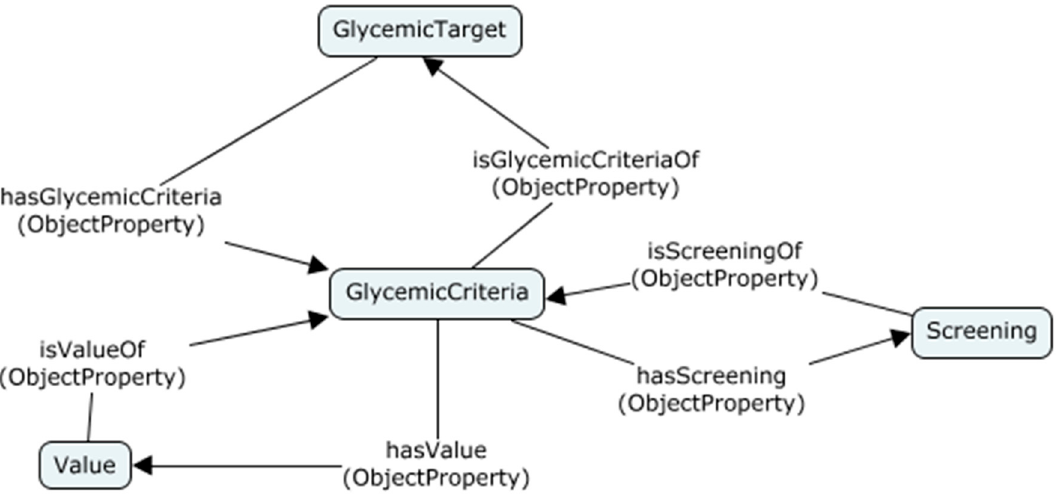
Figure 5. Applying n-ary design pattern 1 .